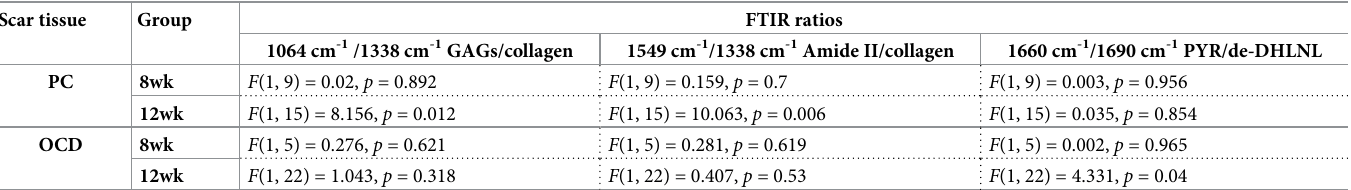
Table 6. Analysis of differences between relative collagen contents and the maturity of collagen-cross-links in scar tissues formed in the PCs and osteochondral defects (OCD) in the CA-treated ACA-treated rabbits. Scar tissue